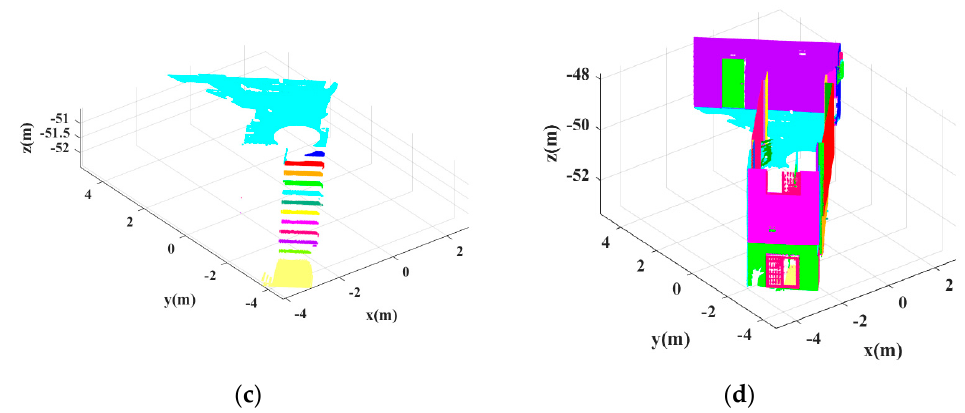
Figure 8. A demonstration of the plane segmentation process. ( a ) Facade segmentation result. ( b ) The remaining points. ( c ) Horizontal plane segmentation result. ( d ) The final result of plane segmentation.